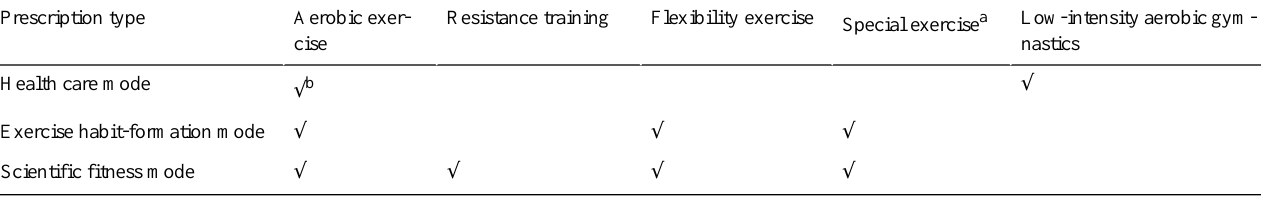
Table 1. Matrix of links between the categories of personalized exercise prescriptions and exercise